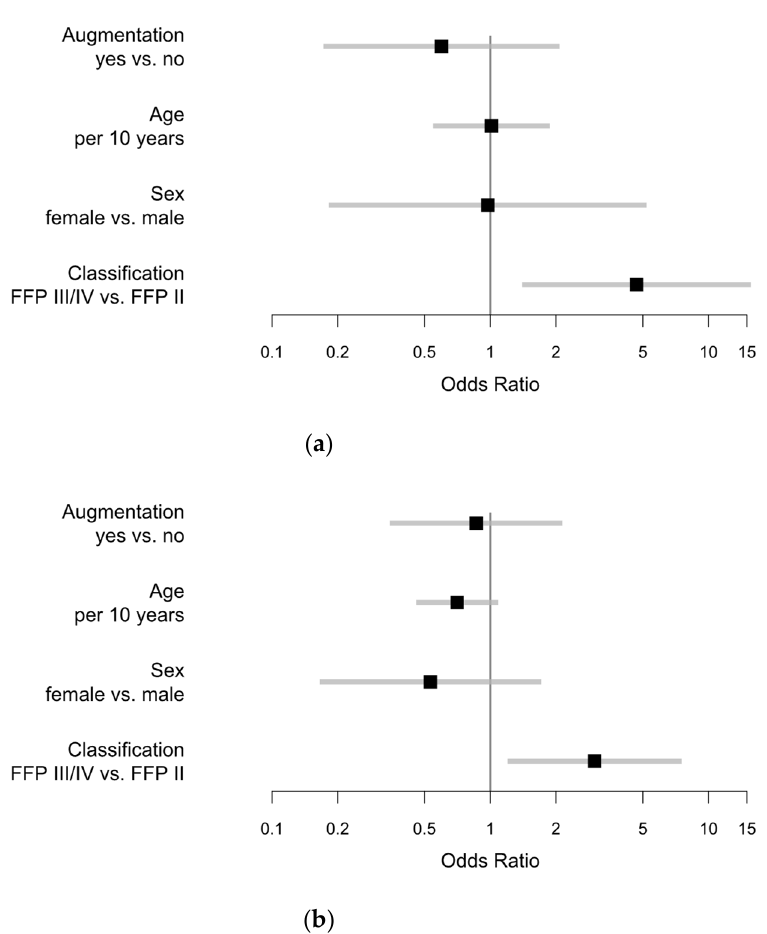
Figure 4. Odds ratios with 95% Wald confidence limits for ( a ) major complications (augmented vs. non-augmented: 0.598 ; female vs. male: 0.974; FFP III–IV vs. FFP II: 4.679) and ( b ) minor complications (augmented vs. non-augmented: OR 0.862; female vs. male: OR 0.532; FFP III–IV vs. FFP II: OR